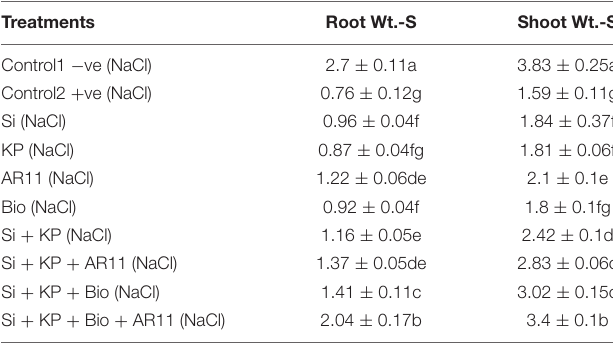
TABLE 5 | Effect of silicon, K 2 HPO 4 , AR11, and biochar morphological attributes under salt stress. Treatments